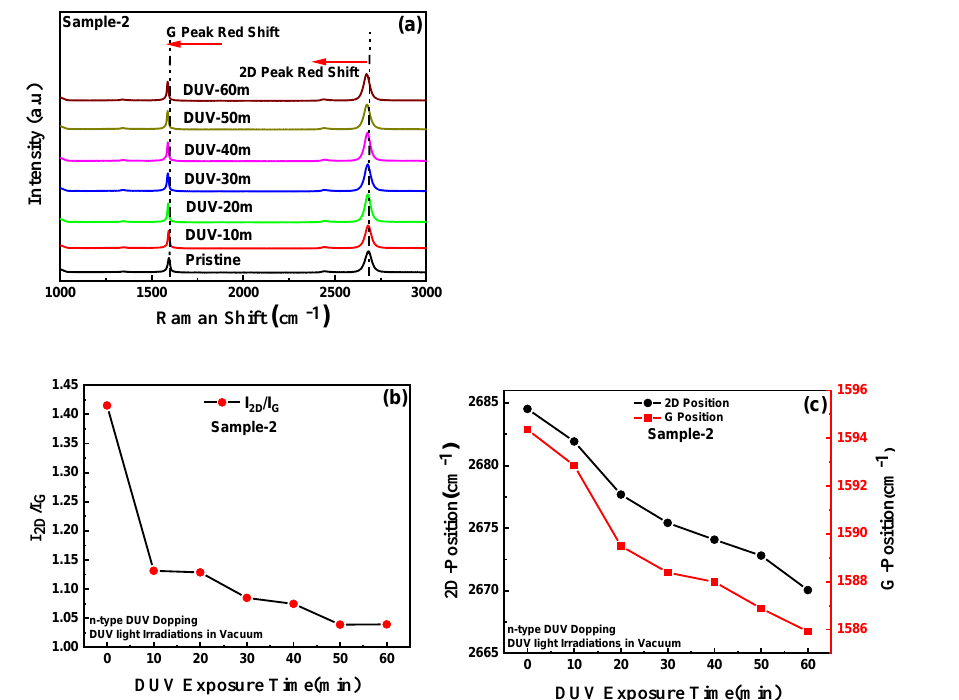
Figure 2. Raman spectroscopy analysis: ( a ) Raman spectra of pristine graphene and p-type doped sample-1 by DUV irradiation in air with different exposure times, showing the blue shift in 2D and G peaks towards higher wavenumbers. ( b ) A shift in the 2D and G peak intensity ratios with an increment in DUV exposure time. ( c ) The 2D and G peak positions as a function of DUV exposure time, showing the shift towards higher wavenumbers with an increase in the p-type doping effect by DUV irradiation in air.